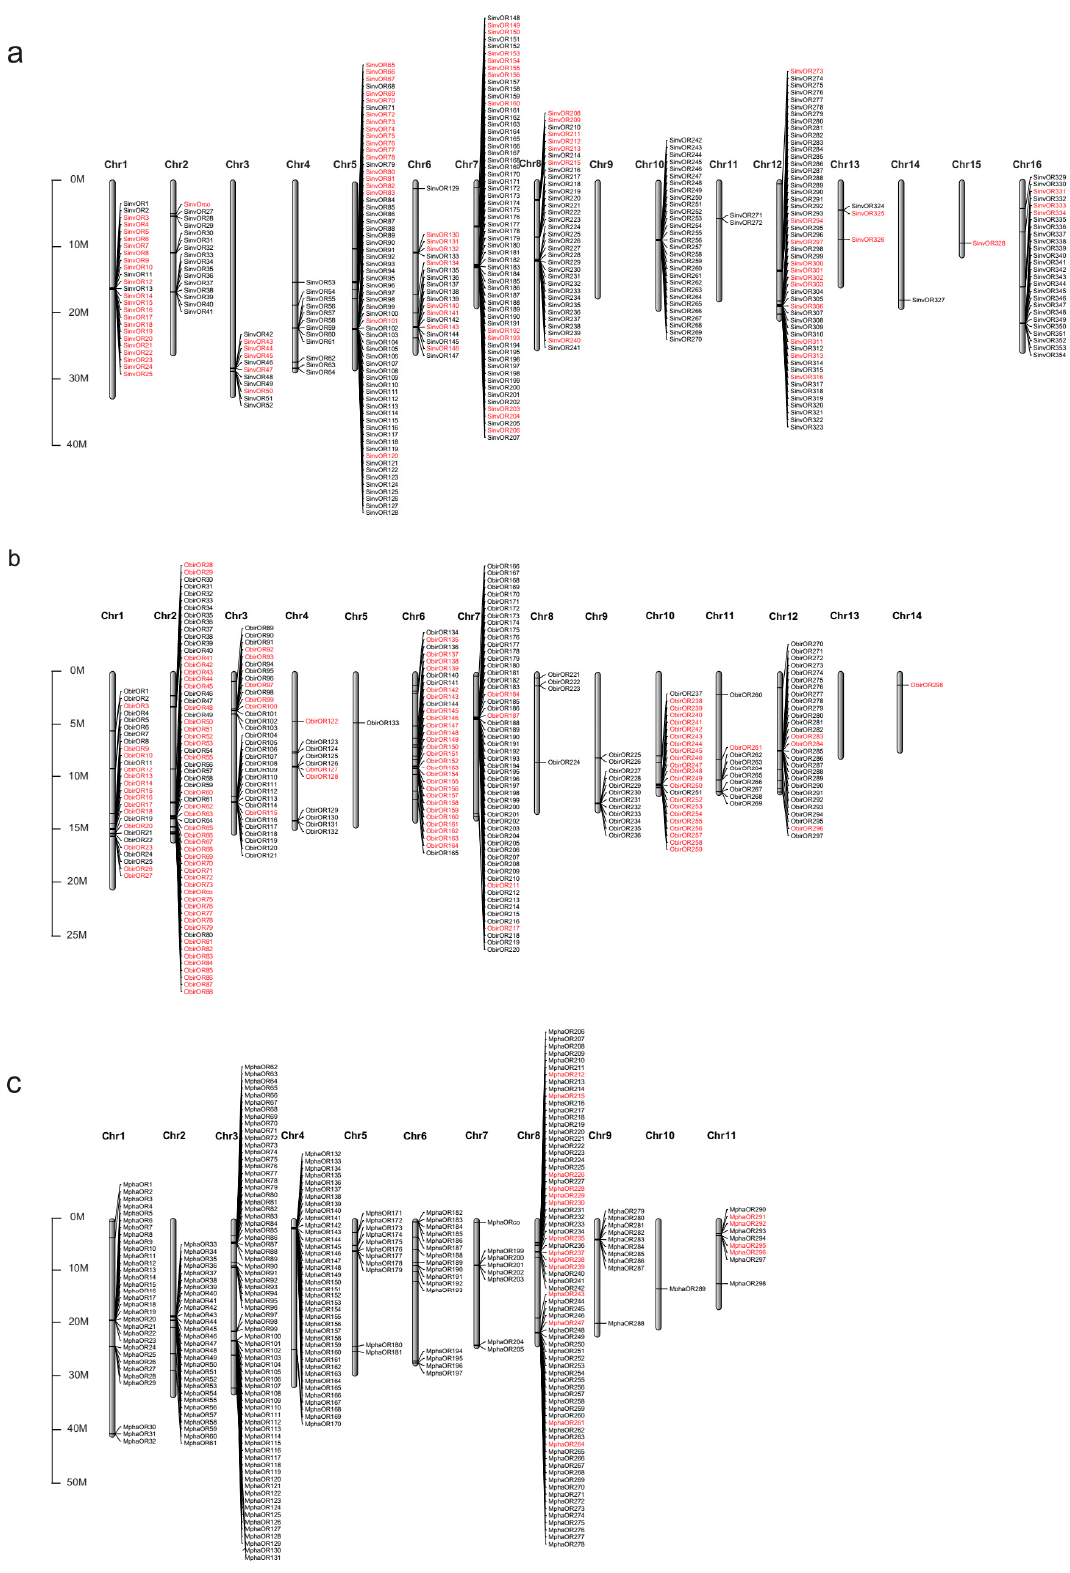
Figure 2. Chromosomal mapping of OR genes in three Formicidae species. ( a – c ) Chromosomal locations of OR genes in S. invicta ( a ), O. biroi ( b ), and M. pharaonis ( c ). The 9-exon OR genes are labeled in